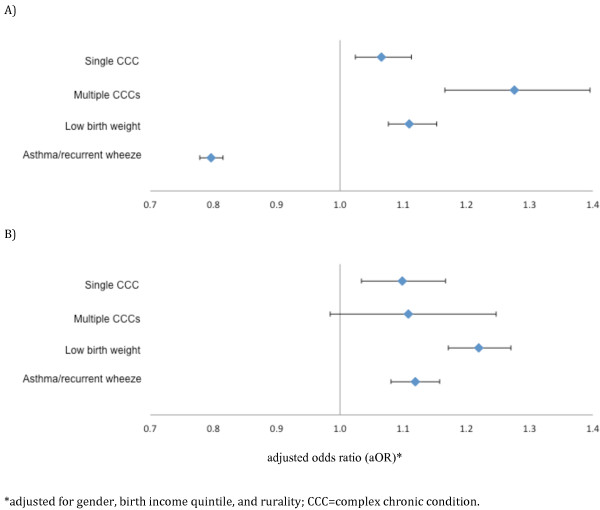
Adjusted* odds ratios (and 99% confidence intervals) of movement (PANEL A) or among those whom moved, a drop in income quintile (or for those in the lowest income quintile, no change in income quintile) (PANEL B) compared with healthy controls.